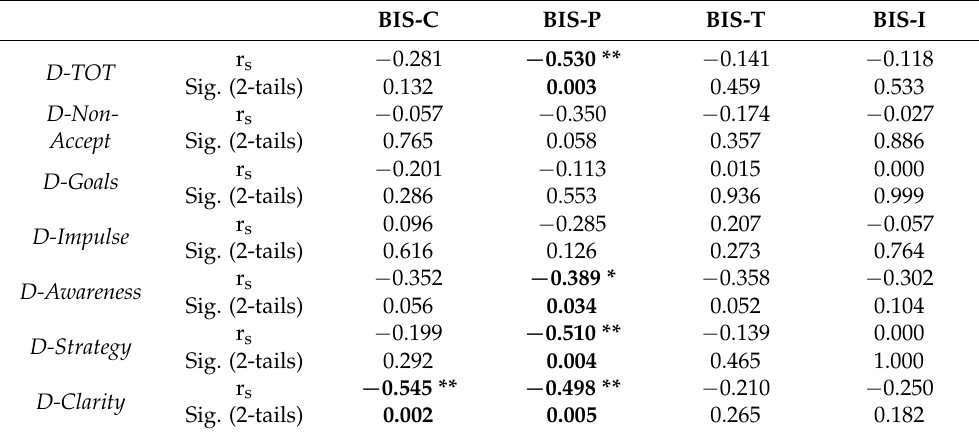
Table 3. Spearman’s correlations between DERS total and subscales and BIS domains among GD